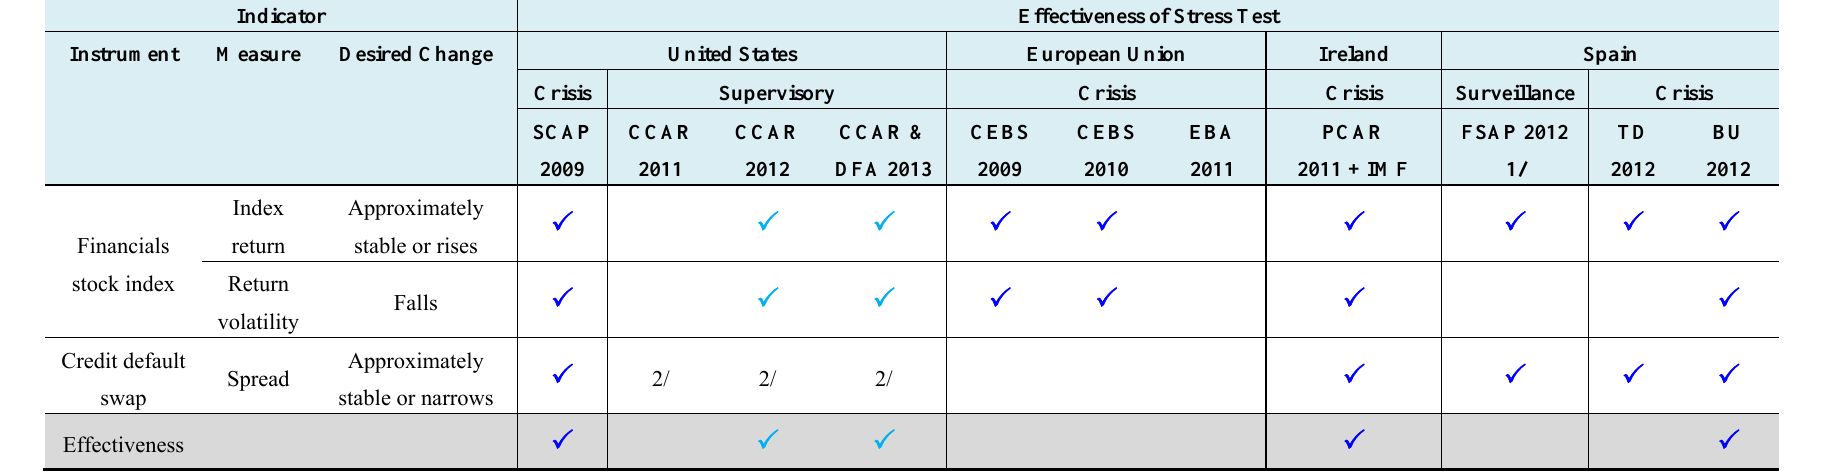
Table 4. Crisis (and Follow-up) Stress Tests: Effectiveness Scorecard.